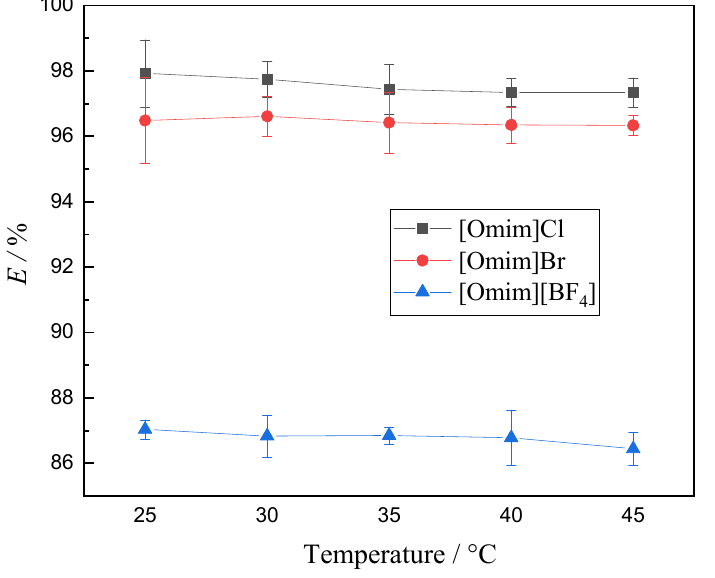
Figure 3. Effect of temperature on the extraction of V (V) (experimental conditions: concentration of V (V) in the aqueous phase 1.75 g · L − 1 , concentration of extractant 0.2 mol · L − 1 , aqueous phase pH 8.051, equilibrium time 60 s; relative standard uncertainty: confidence probability p = 95%, u rA =0.66%, u rB =0.35%, u r =0.75%).